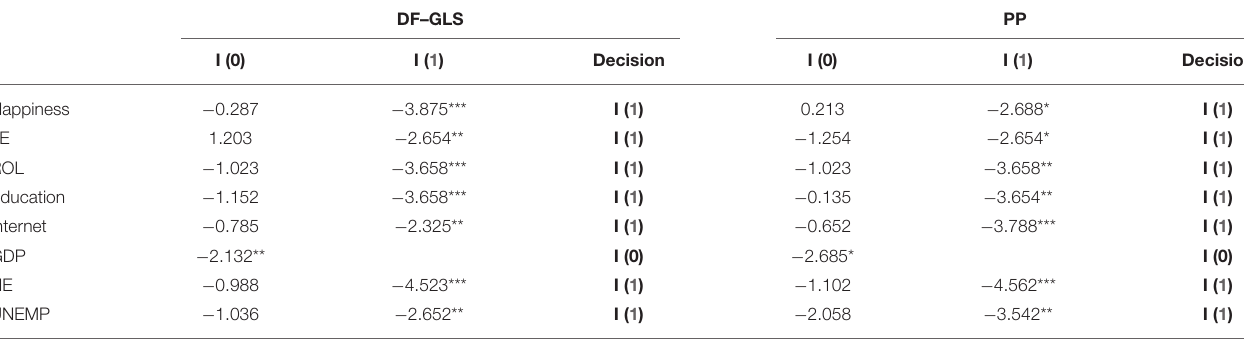
TABLE 2 | Unit root testing.